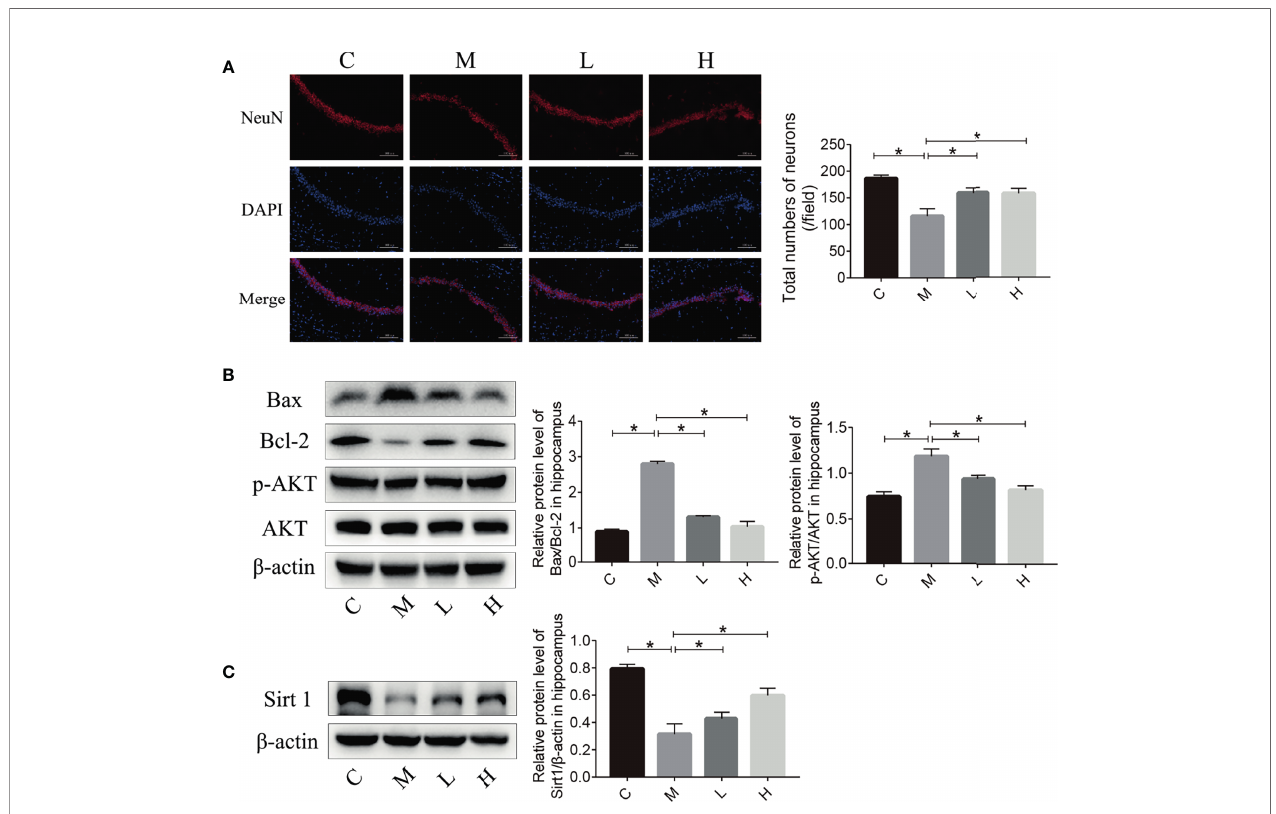
FIGURE 3 | The probiotic combination reduced neuronal death and prevented the decrease in Sirt 1 expression in the hippocampus of SAMP8 mice. (A) Photomicrographs and quantitative analysis of the number of neurons in the hippocampus, analysed by NeuN immunostaining. (B) The effect of the probiotic combination on the expression levels of Bax, Bcl-2, p-AKT and AKT in the hippocampus. (C) The effect of the probiotic combination on the expression level of Sirt 1 in the hippocampus. C: control group (n = 4), M: model group (n = 4), L: low-dose probiotics group (n = 4), H: high-dose probiotics group (n = 4). Data are presented as the means ± SD. *p <